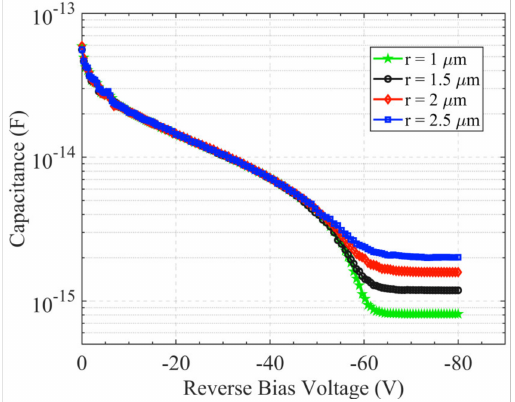
Figure 6. Capacitance of the hemispherical electrode